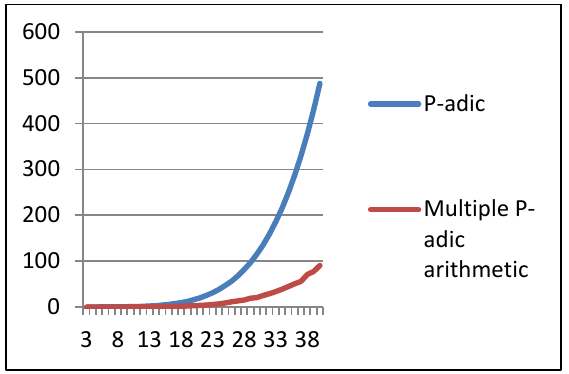
Fig. 8. Polynomial method to calculate vertical axis: the average implementation time in second horizontal axis: the matrix size